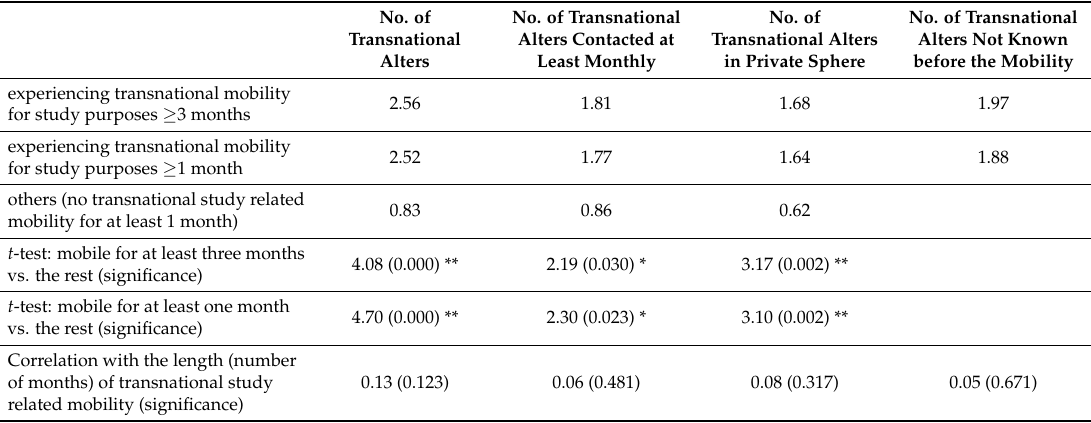
Table 4. Statements indicating different reflexivity